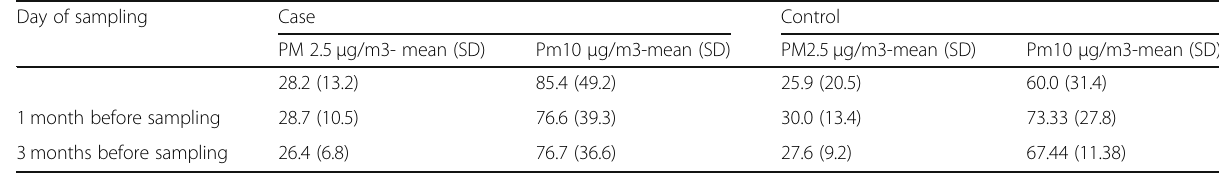
Table 5 Mean daily concentration of particulate matters exposure in time intervals in studied subjects Day of sampling